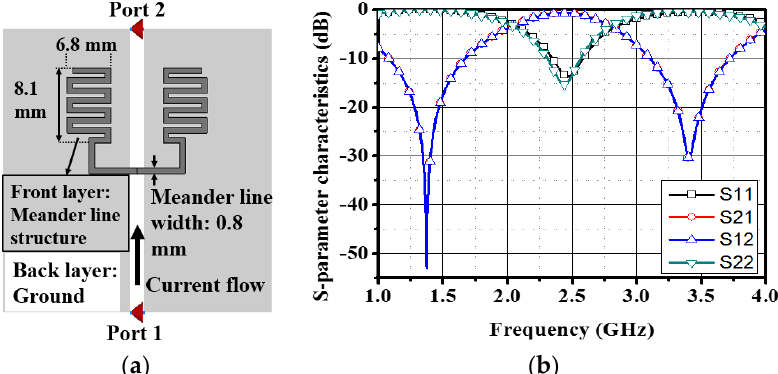
Figure 5. Meander line resonator with band pass characteristics: ( a ) Geometry of the meander line structure and ( b ) S-parameter characteristics.